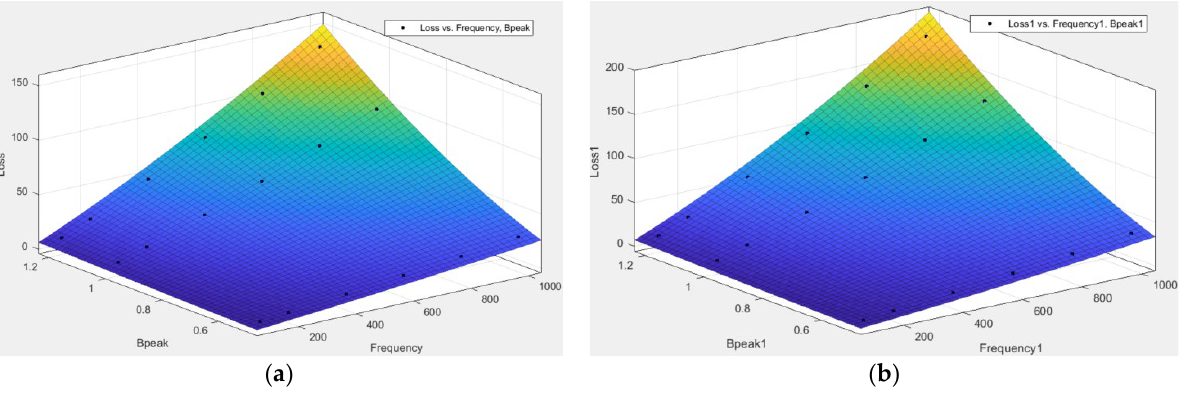
Figure 23. Watts/kg power loss to derive Steinmetz equations for, ( a ) Somaloy 130i-5P (stator segments), ( b ) Somaloy 700 HR 3P (flux concentrating rotor poles).